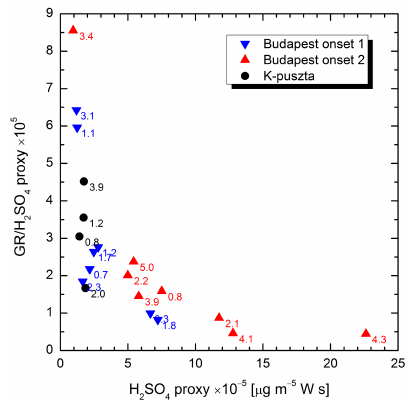
Figure 7. Dependence of the growth rate of NPF for a unity H 2 SO 4 proxy on the proxy value separately for the onsets 1 and 2 of the events with double start in the near-city background of Budapest and for the regional NPF at the K-puszta station on identical days. The numbers next to the symbols express J 6 in a unit of cm − 3 s − 1